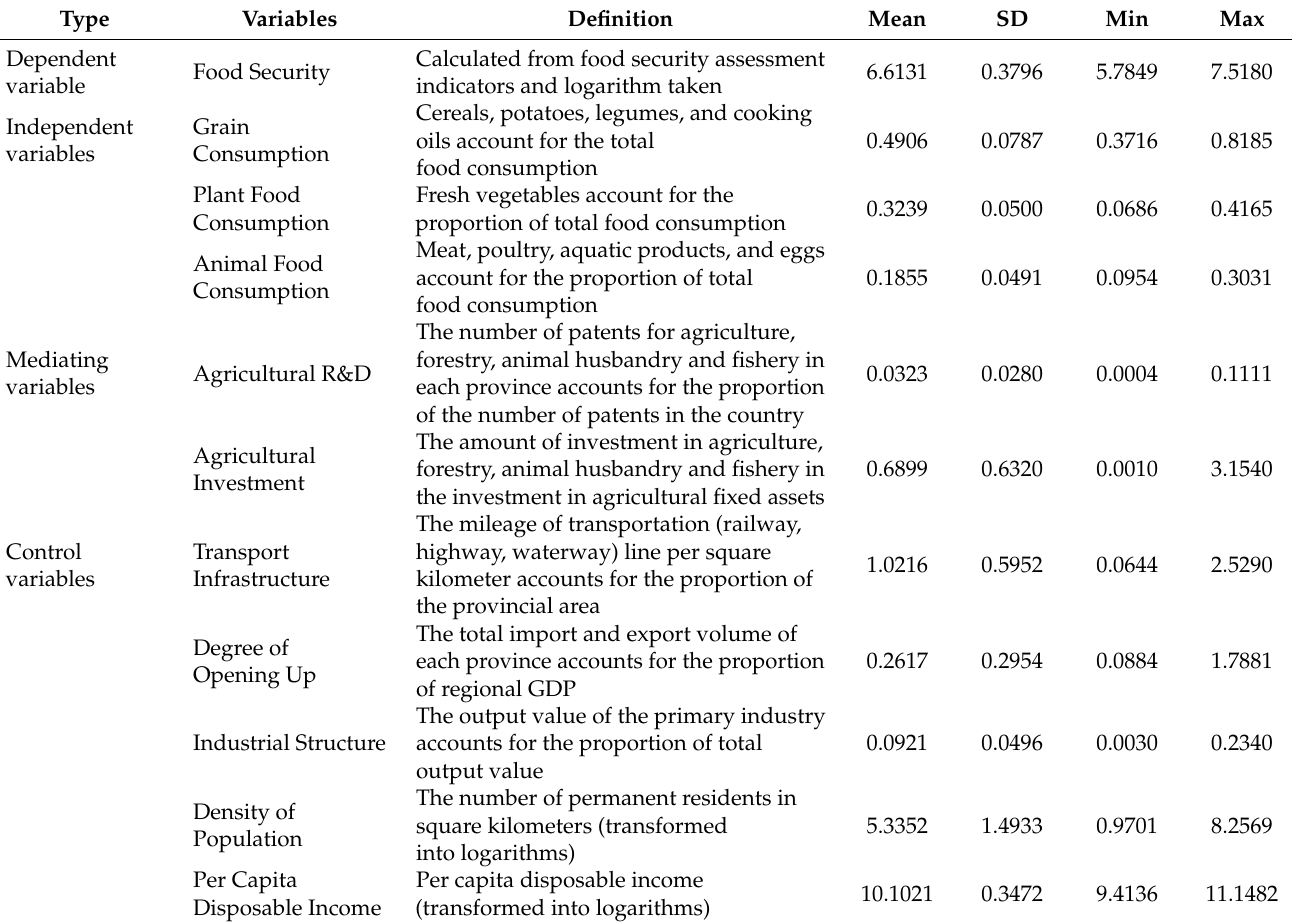
Table 4. Definition of major variables and descriptive statistical